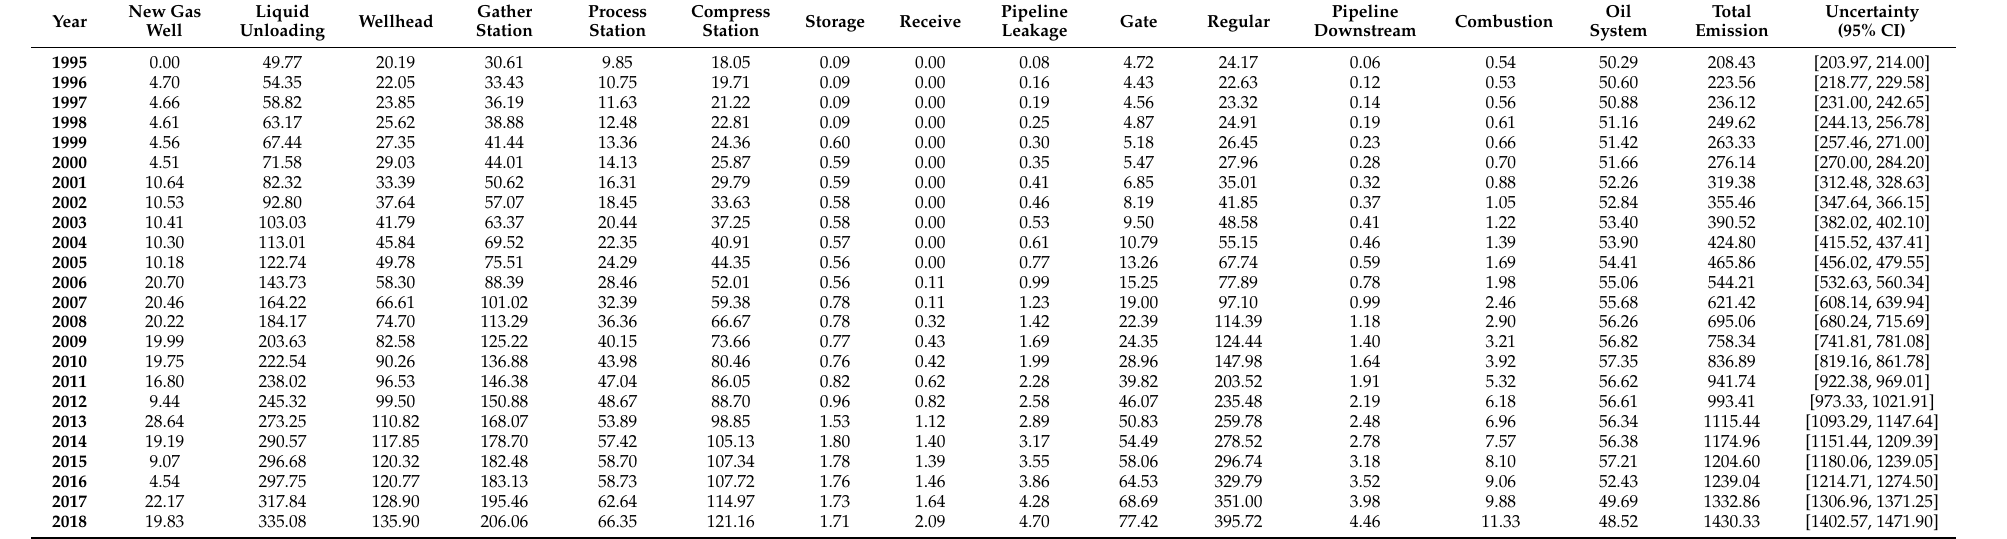
Table 2. Methane emission inventory from China’s oil and natural gas sector, 1995–2018. Unit of methane emission is